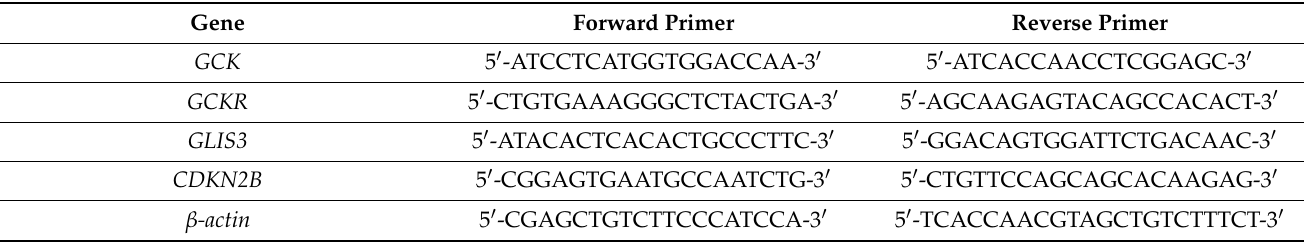
Table 1. Primer sequences for